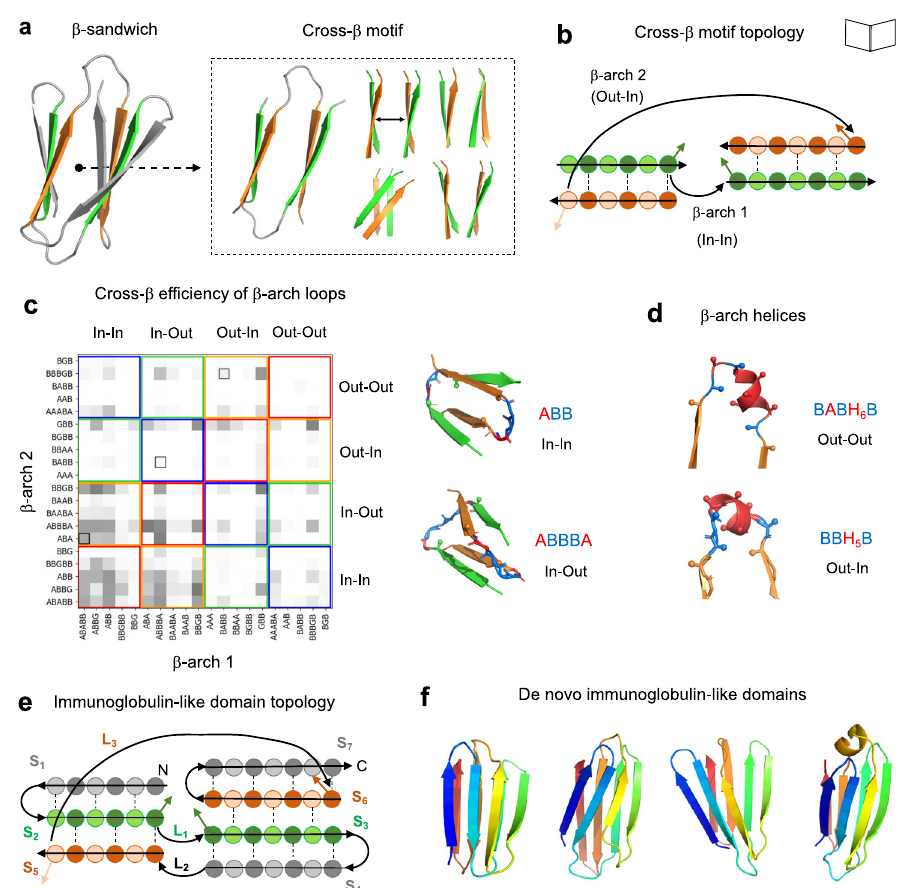
Fig.2|Designrulesforcross- β motifsin β -sandwiches.a Cartoonrepresentation of a 7-stranded immunoglobulin-like domain model formed by two β -sheets packing face-to-face, and the corresponding cross- β motif, which generates translationsandrotationsbetweenthetwoopposing β -sheets. b Topologydiagram of a cross- β motif with circles and arrows representing β -strand residue positions and connections, respectively. Dark- and light-colored circles correspond to resi- dues with sidechains pointing inwards or outwards from the β -sandwich, respec- tively. c Ef fi ciency of pairs of common β -arch loop geometries (described with ABEGO backbone torsions) in forming cross- β motifs obtained from Rosetta fold- ing simulations (gray shaded squares). Loop geometries were classi fi ed in four groups according to the sidechain directions of the adjacent residues. Colored squaresgrouppairsofloopsthat,duetotheirsidechainorientations,havedifferent requirements in β -strand length:inred orblue, ifall β -strandsneed anodd oreven